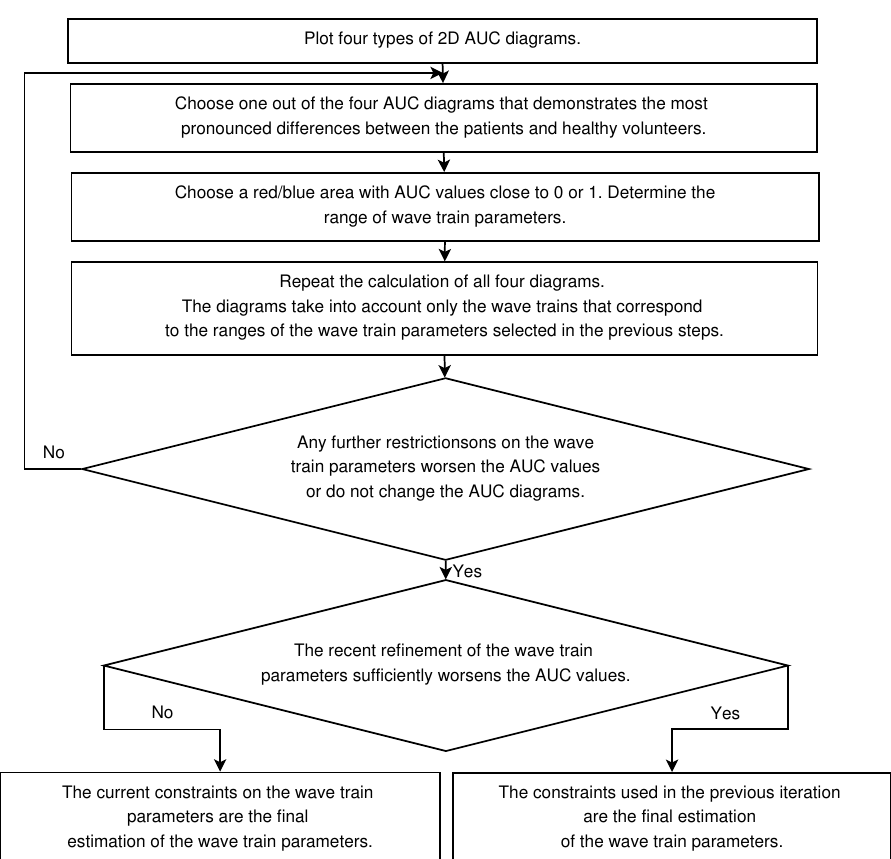
Figure 11. The flowchart of the method of analysis of the wave train electrical activity in EMG